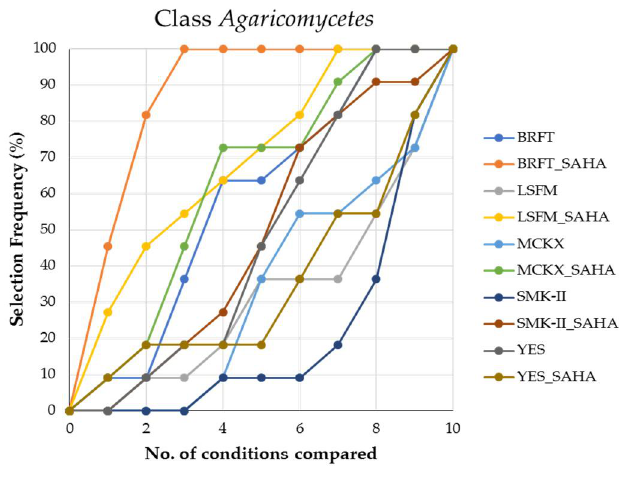
Figure 8. Ranking of the different conditions based on the exclusive chemical diversity generated from fermentations of the class Agaricomycetes ( n = 11).